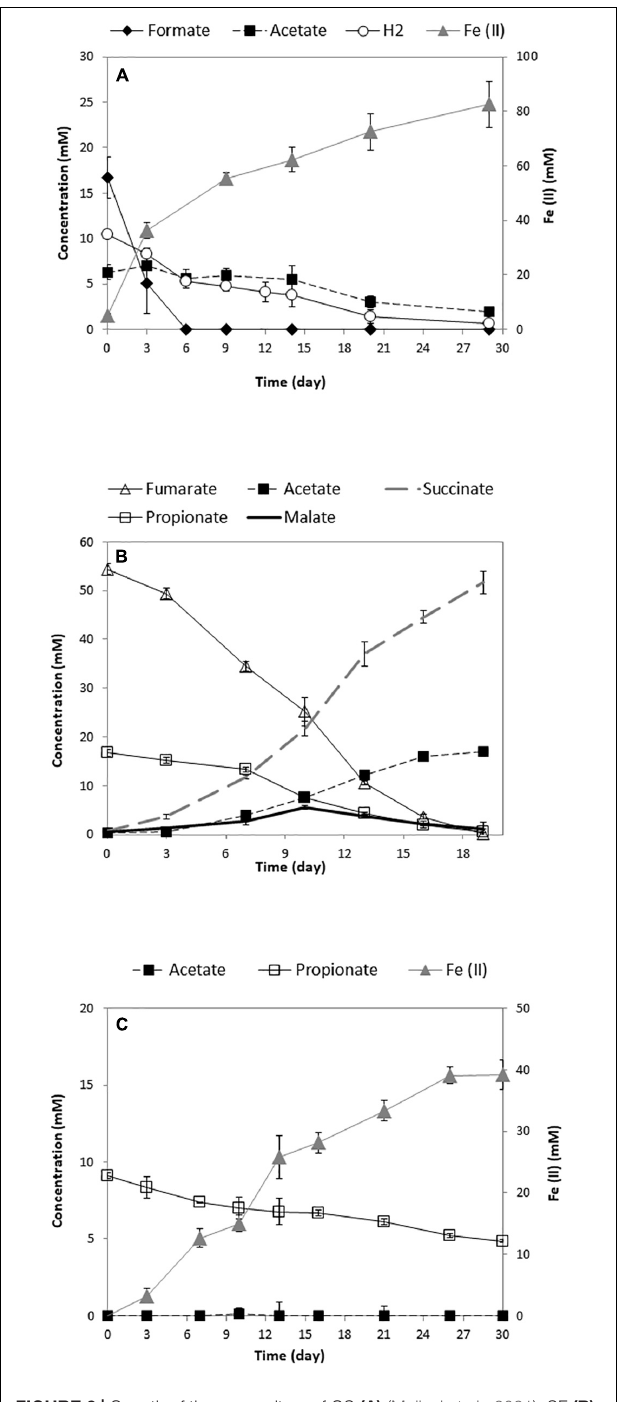
FIGURE 2 | Growth of the pure culture of GS (A) (Mollaei et al., 2021), SF (B) , and the SF-GS coculture (C) . The concentration of hydrogen was shown as mmol/L liquid. Data are means of